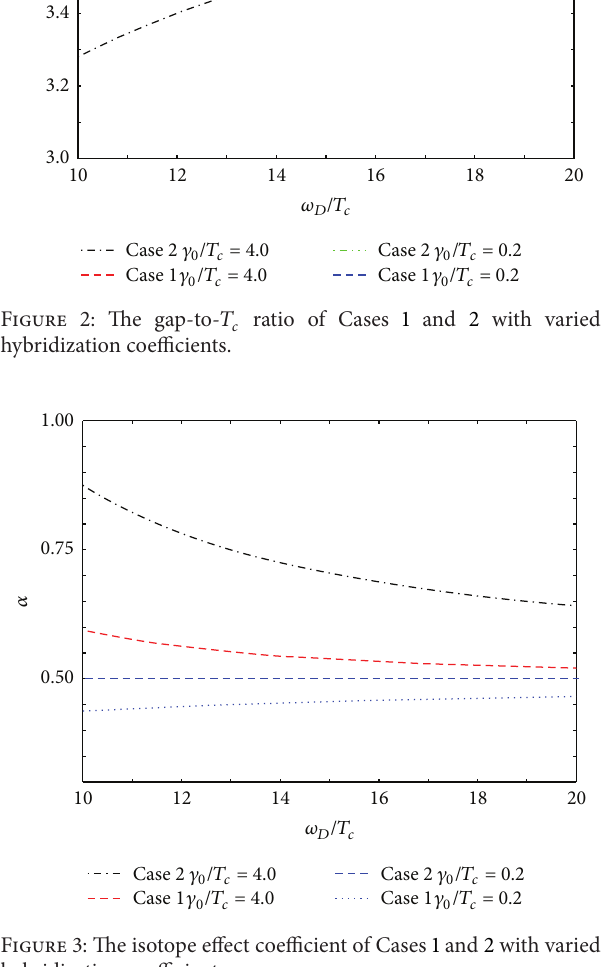
Figure 3: The isotope effect coefficient of Cases 1 and 2 with varied hybridization